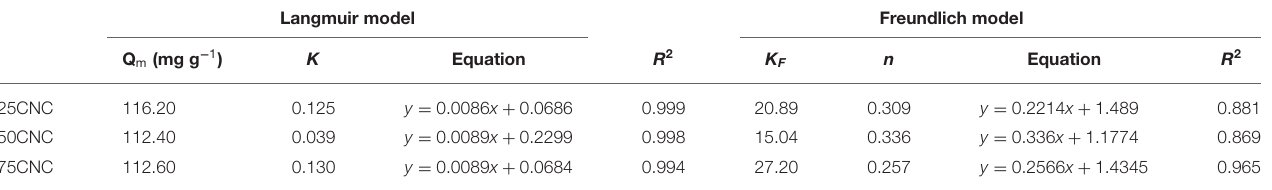
TABLE 3 | Langmuir and Freundlich isothermal adsorption constant, equation, and regression coefficient of the linearized plot for the adsorption of MB.